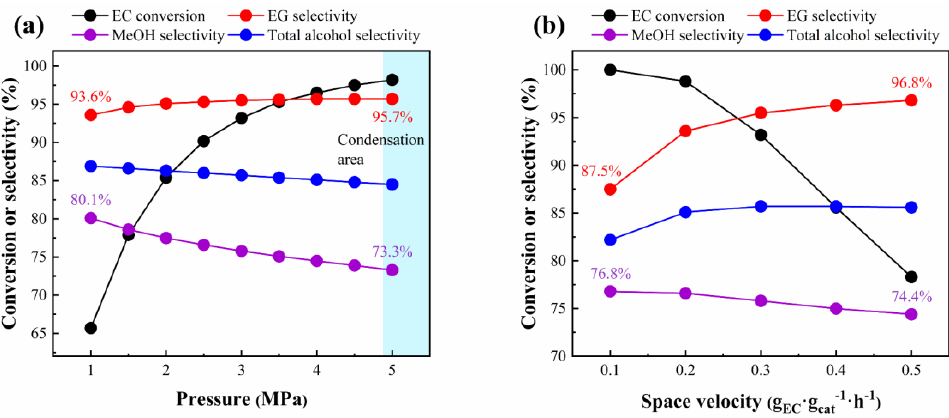
Figure 9. Reactor performance of the boiling water-cooled reactor under the conditions of ( a ) 1 –